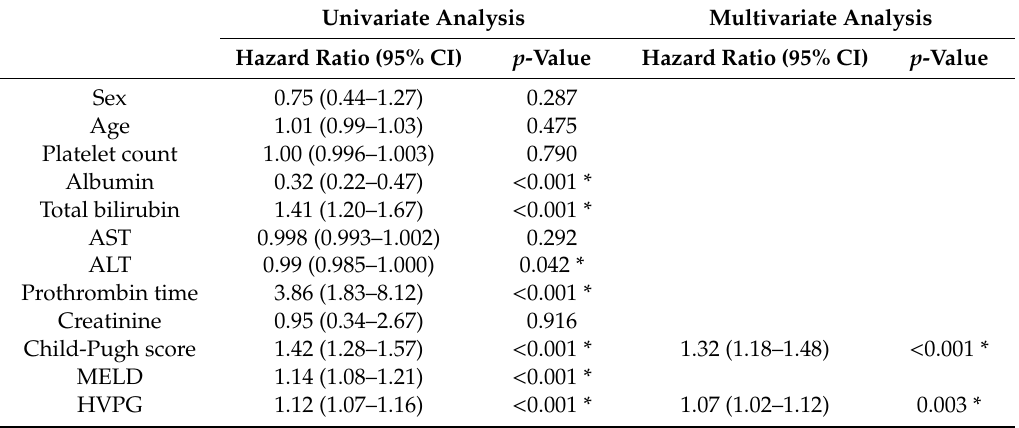
Table 2. Univariate and multivariate regression analysis using the Cox proportional hazards model to predict the risk of